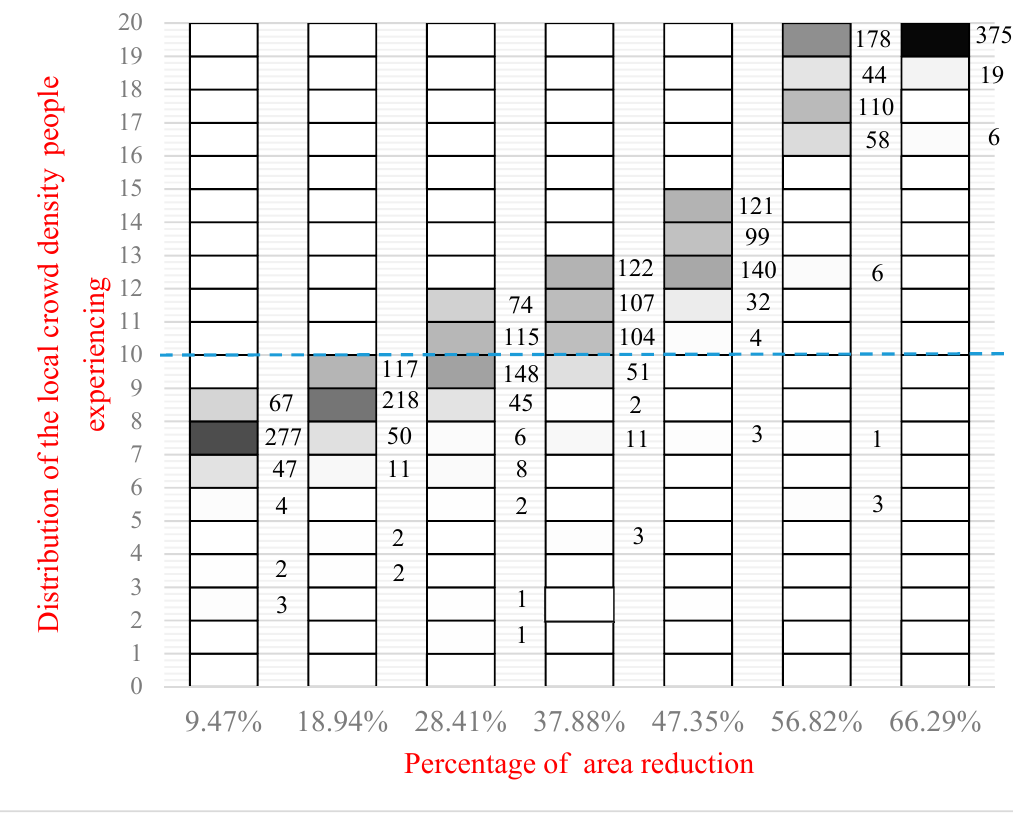
Figure 12. The distribution of local density that 400 agents experience when the lower wall moves by 0.5 m, 1.0 m, 1.5 m, 2.0 m, 2.5 m, 3.0 m, and 3.5 m to compress the occupied space.